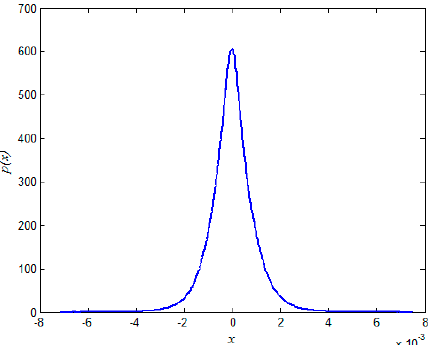
Figure 4. Typical example of the estimated probability density function (PDF) for the elements in A 1 .